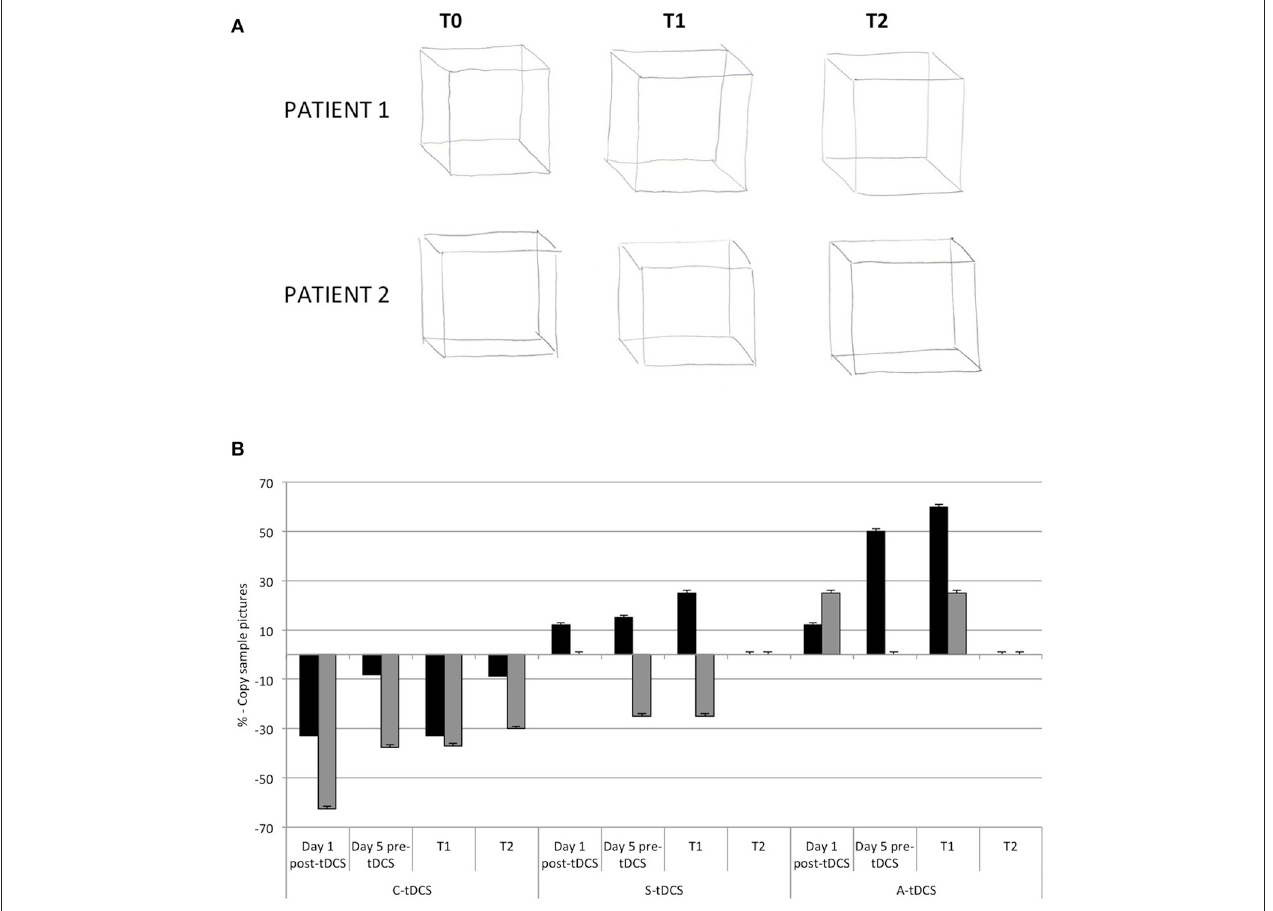
FIGURE 4 | (A) The tremor graft pre (T0), and post (T1 and T2) C-tDCS in both patients. (B) The histogram showed qualitative analysis in the percentage differences of tremor after tDCS in both patients. Zero percent is baseline